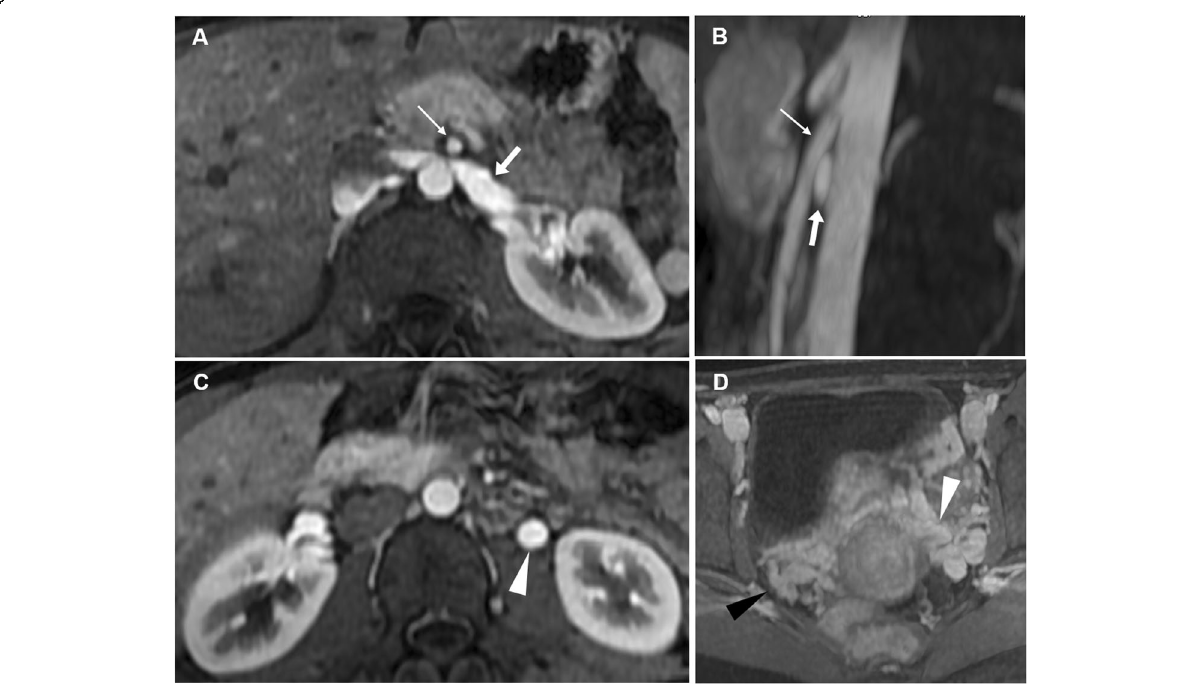
Fig. 23 Pelvic varices from nutcracker syndrome in a 24-year-old woman with severe pelvic pain. Axial gadolinium-enhanced fat-suppressed T1- weighted images ( a , c ) demonstrate compression of left renal vein ( ‘ beak sign ’ , arrow) between the abdominal aorta and superior mesenteric artery (thin arrow) and enlarged left gonadal vein (arrowhead). Additional sagittal maximum-intensity projection (MIP) reconstruction ( b ) demonstrates the left renal vein (arrow) within a narrow angle between the abdominal aorta and the superior mesenteric artery (thin arrow), consistent with ‘ nutcracker syndrome ’ . Axial angiographic MIP image ( d ) demonstrates dilated, engorged left parametrial and uterine veins